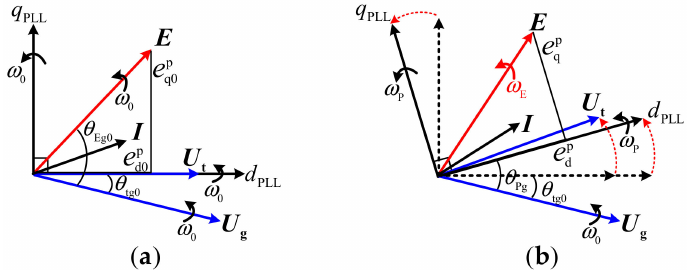
Figure 3. Vector diagram for the VSC’s internal voltage. ( a ) At a steady state. ( b ) During the dynamic process. PLL: Phase-locked